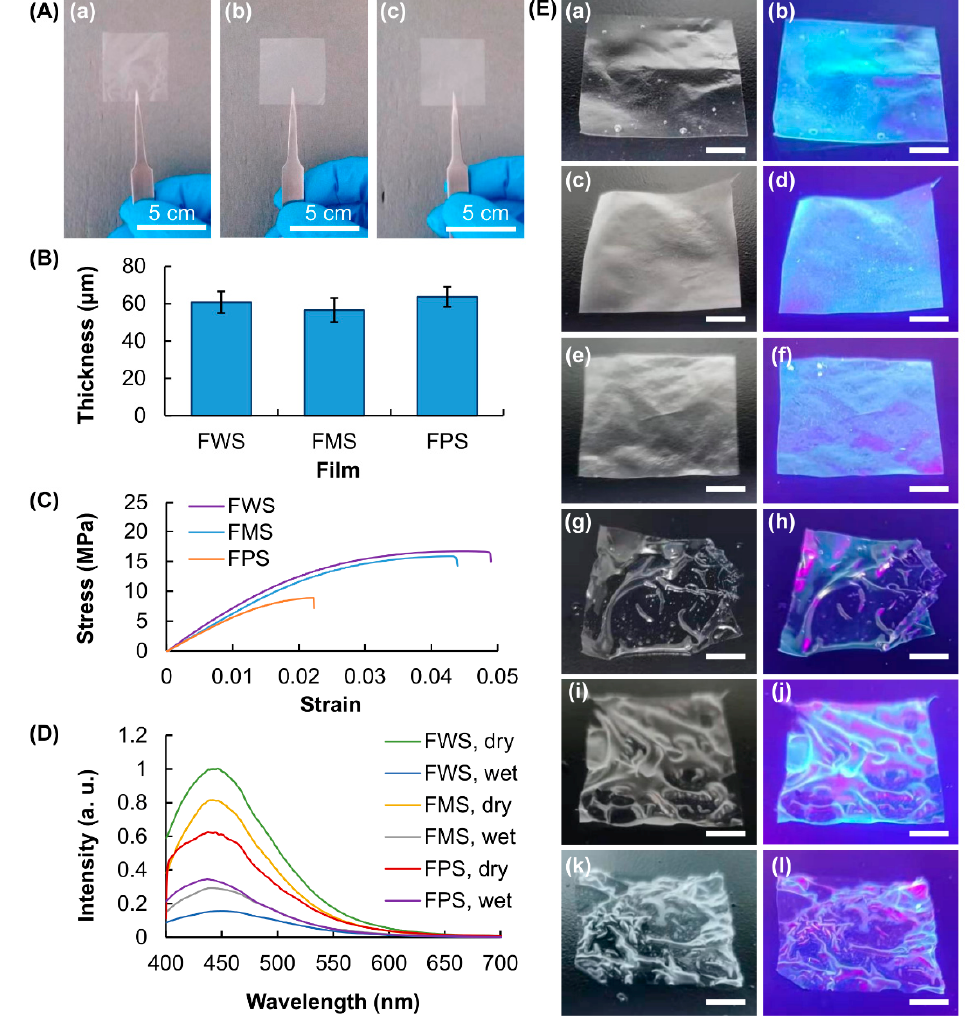
Figure 2. ( A ) Photos of the films generated from ( a ) WS, ( b ) MS and ( c ) PS. ( B ) Thickness and ( C ) tensile strength of the water chestnut starch film (FWS), maize starch film (FMS) and potato starch film (FPS). ( D ) Photoluminescence (PL) spectra of dry and swollen films. ( E ) Images of ( a , b , g , h ) FWS, ( c , d , i , j ) FMS and ( e , f , k , l ) FPS under ( a , c , e , g , i , k ) white light and ( b , d , f , h , j , l ) UV light. The wavelength of UV light is at 365 nm. Scale bar = 1 cm.